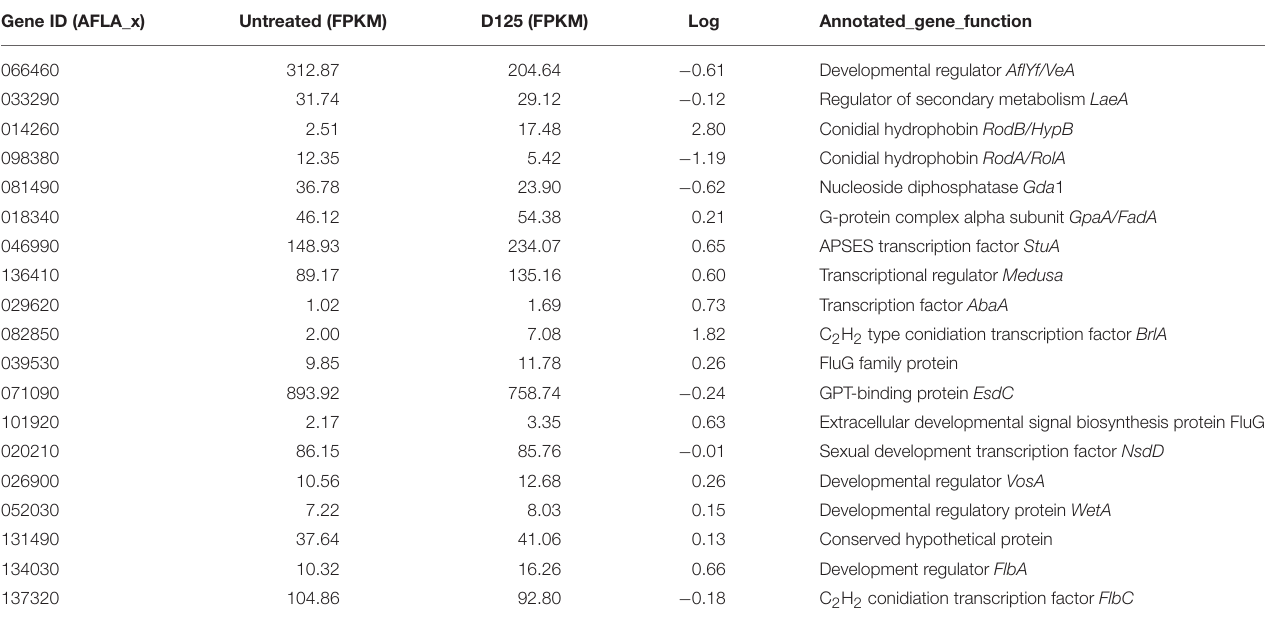
TABLE 4 | Transcriptional activity of genes involved in A. flavus